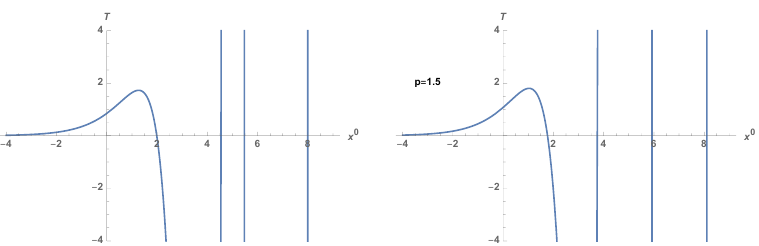
Figure 28 . Evolution of the tachyon for the exponential rolling tachyon deformation, left as derived from the level 0 truncated action, and right from the shifted 3-point function.